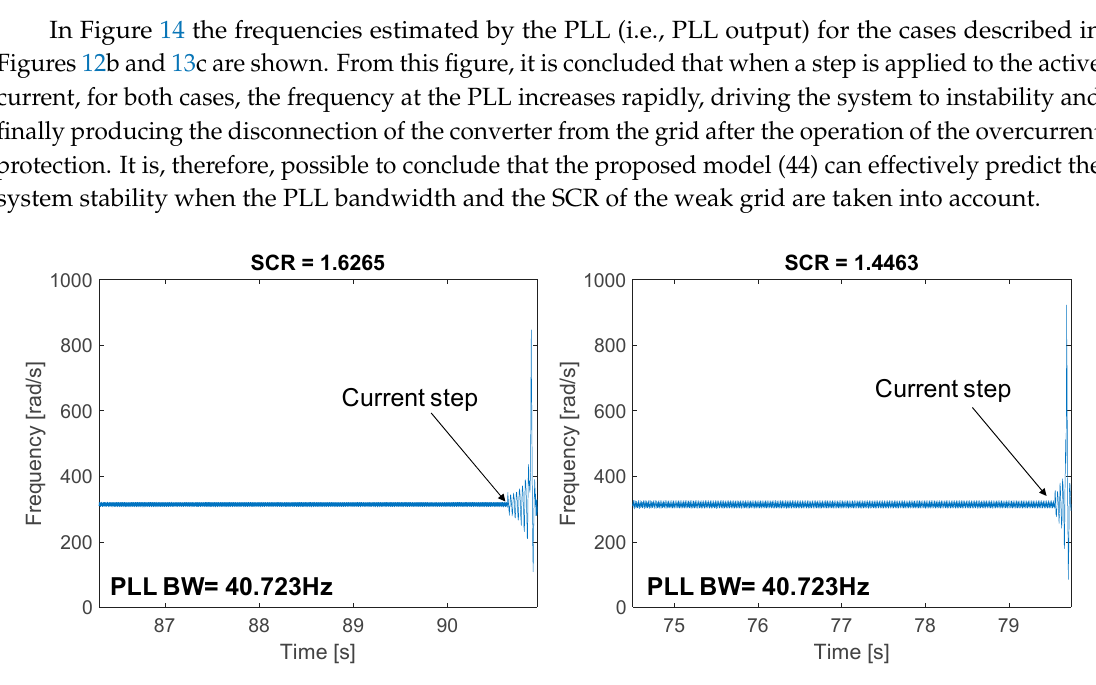
Figure 14. Frequency at the PLL output in the cases depicted in Figures 12b and 13c (current step)—Matlab data logging of the experimental waveforms.